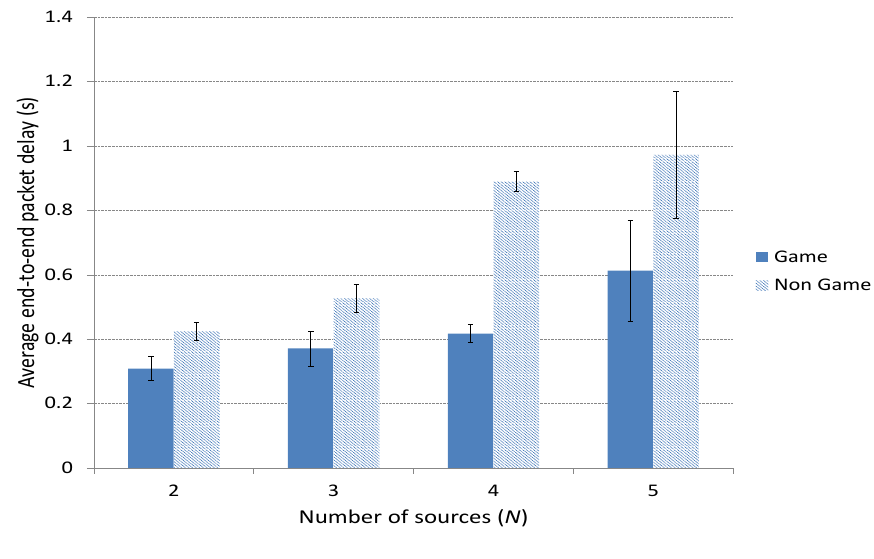
Figure 10. Average end-to-end packet delay.